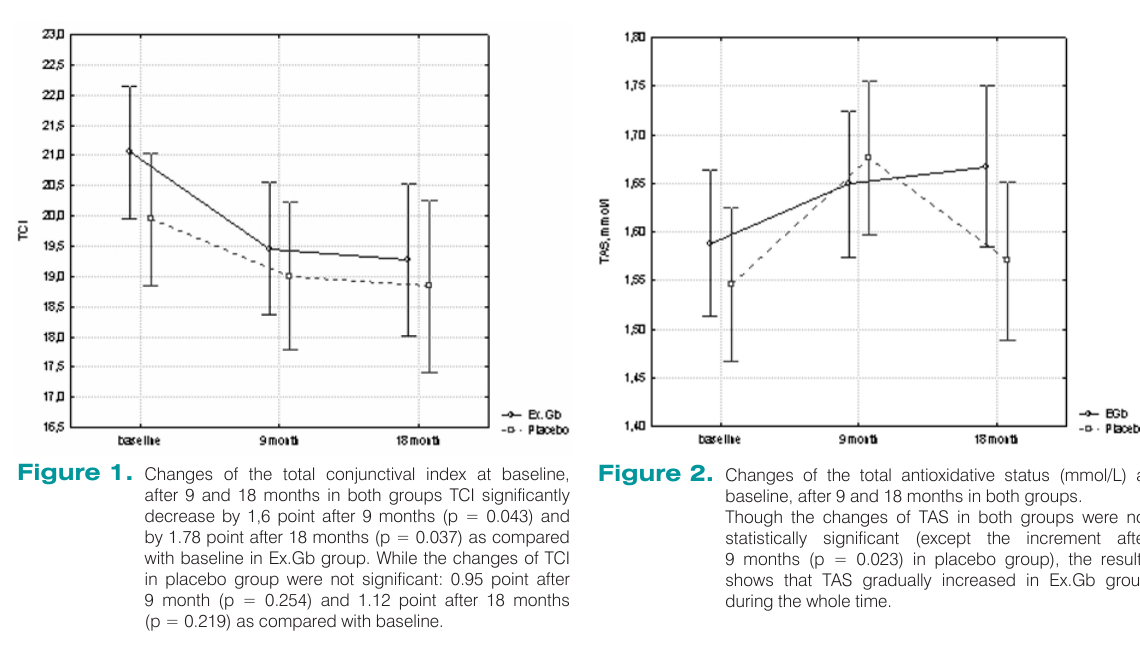
Figure 2. Changes of the total antioxidative status (mmol/L) at baseline, after 9 and 18 months in both groups. Though the changes of TAS in both groups were not statistically significant (except the increment after 9 months (p = 0.023) in placebo group), the results shows that TAS gradually increased in Ex.Gb group during the whole time.